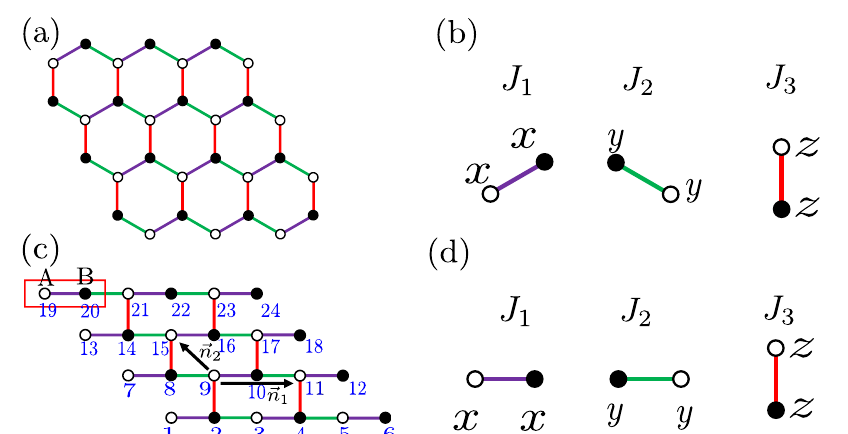
Figure 1: (a) A honeycomb lattice on which the Hamiltonian in Eq. (1) is defined. (b) The terms in Hamiltonian (1). (c) Brick-wall representation of the honeycomb lattice. A site is labeled by the unit cell vector ⃗ r = l sublattice index β = A , B , where ⃗ n circles represent sublattices A and B, respectively. The ordering of sites is indicated by numbers that defines a 1D path for the Jordan-Wigner transformation.